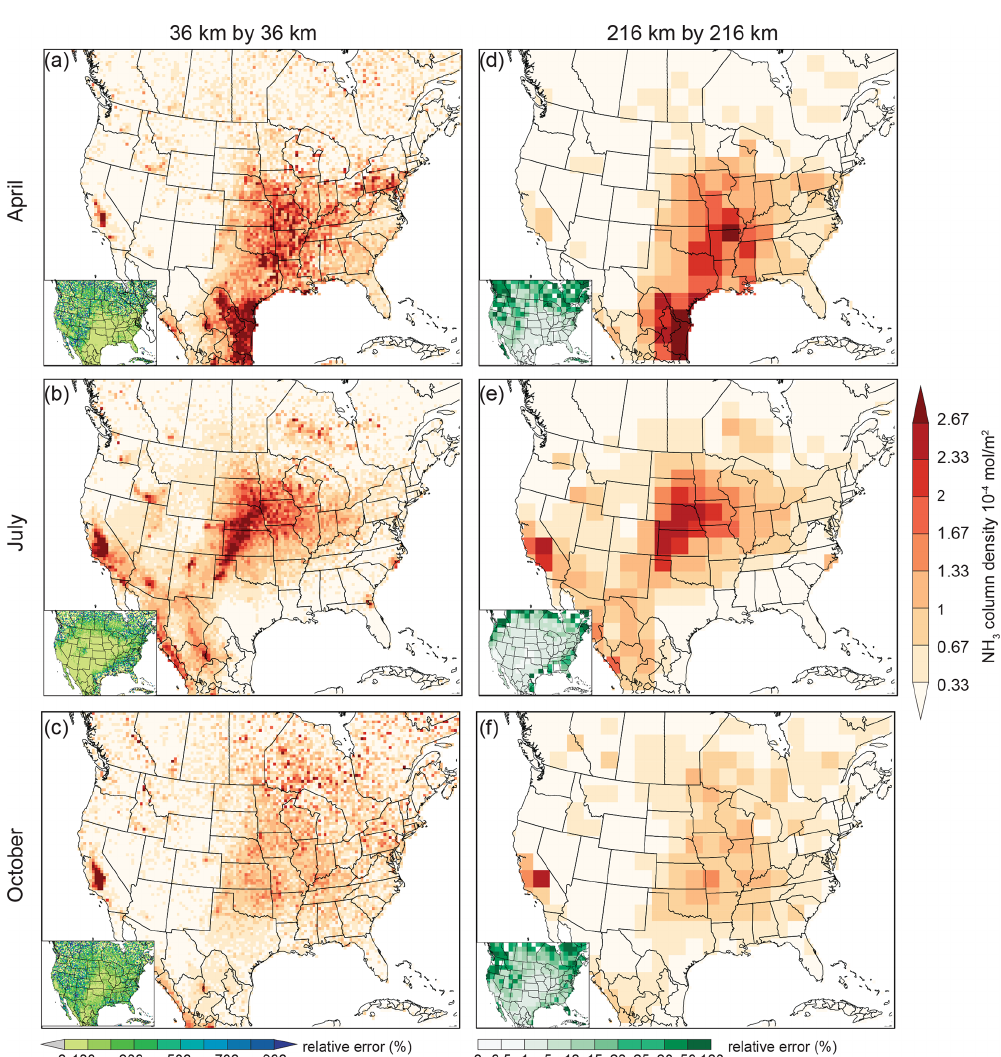
Figure 1. IASI monthly average NH 3 column density in April, July, and October 2011 at 36km by 36km (a, b, c) and 216km by 216km (d, e, f) resolutions within the model simulation domain of this study. The average relative error associated with the column density is shown in the corner of each